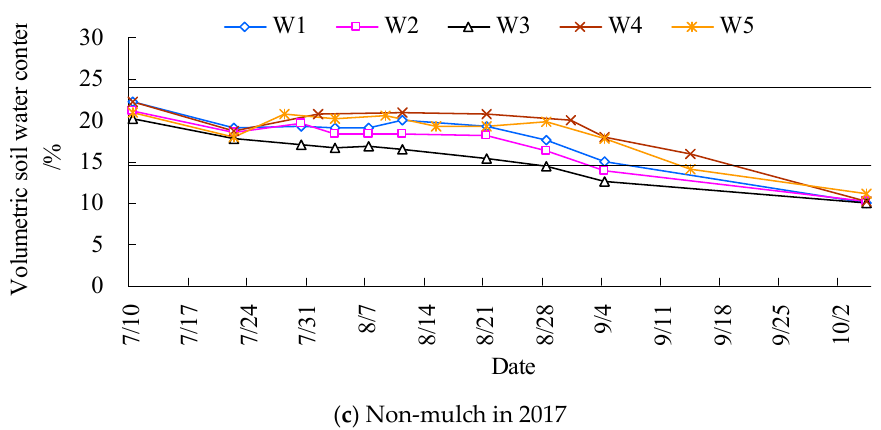
Figure 2. Volumetric soil water content for W1 – W5 treatments throughout the season for drip-irrigated summer maize in Xinjiang, China. ( a ) Partial mulch in 2016; ( b ) Partial mulch in 2017; ( c ) Non-mulch in 2017.